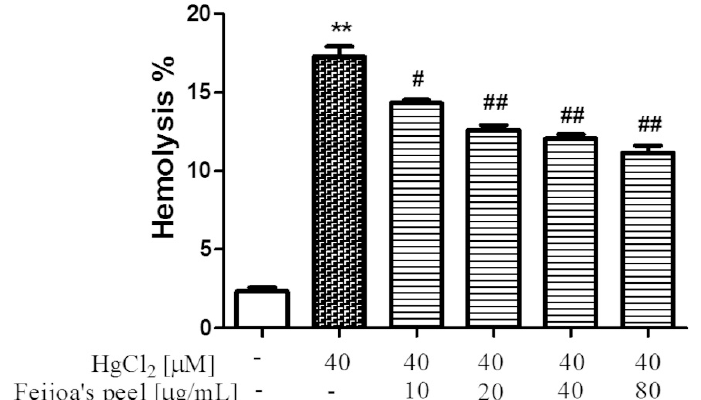
Figure 1. Feijoa peel acetonic extract reduces Hg-induced hemolysis. Cells were treated with 40 µM HgCl 2 for 24 h with increasing acetonic extract concentrations. Data are the means ± standard errors of the mean (SEM) ( n = 9). Statistical significance was calculated by one-way ANOVA followed by Tukey’s test. ** ( p < 0.05) indicates a significant di ff erence from cells lacking HgCl 2 treatment. # ( p < 0.05) and ## ( p < 0.01) indicate significant differences from cells lacking Feijoa extract treatment.